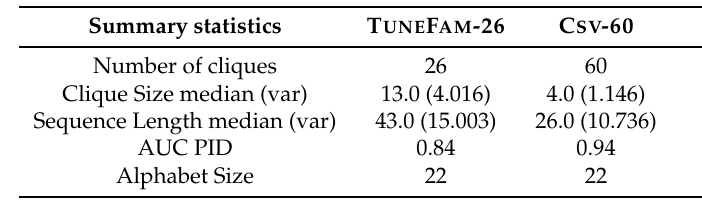
Table 2. Summary statistics for the datasets considered in our work. We also present the Area Under the Curve (AUC) value for the Receiver Operating Characteristic curve (ROC) on the Percentage Sequence Identity (PID). Given two aligned sequences, the PID score is simply the number of identical positions in the alignment divided by the number of aligned positions [62]. The higher the AUC PID the more similar the sequences are in a clique compared to the whole dataset. It should be noted that the alphabet size presented corresponds to the number of unique symbols appearing in the